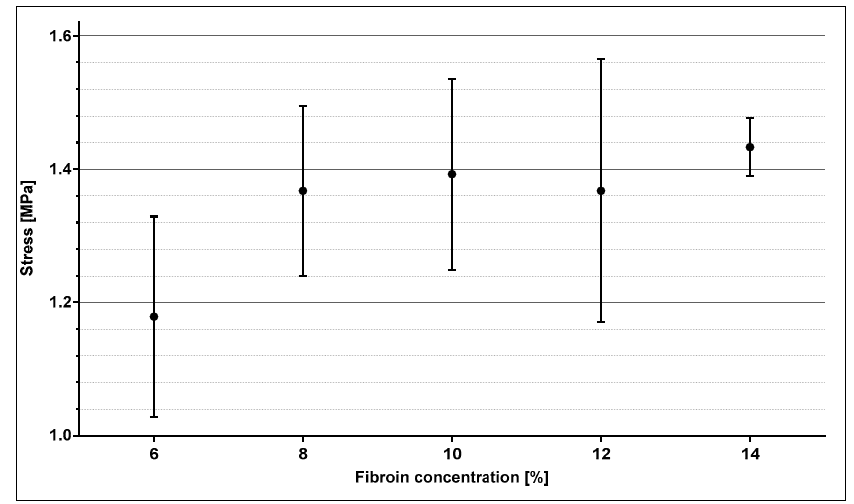
Figure 6. Mean value and standard deviation of maximum stress of the different membranes in relation to fibroin concentration.